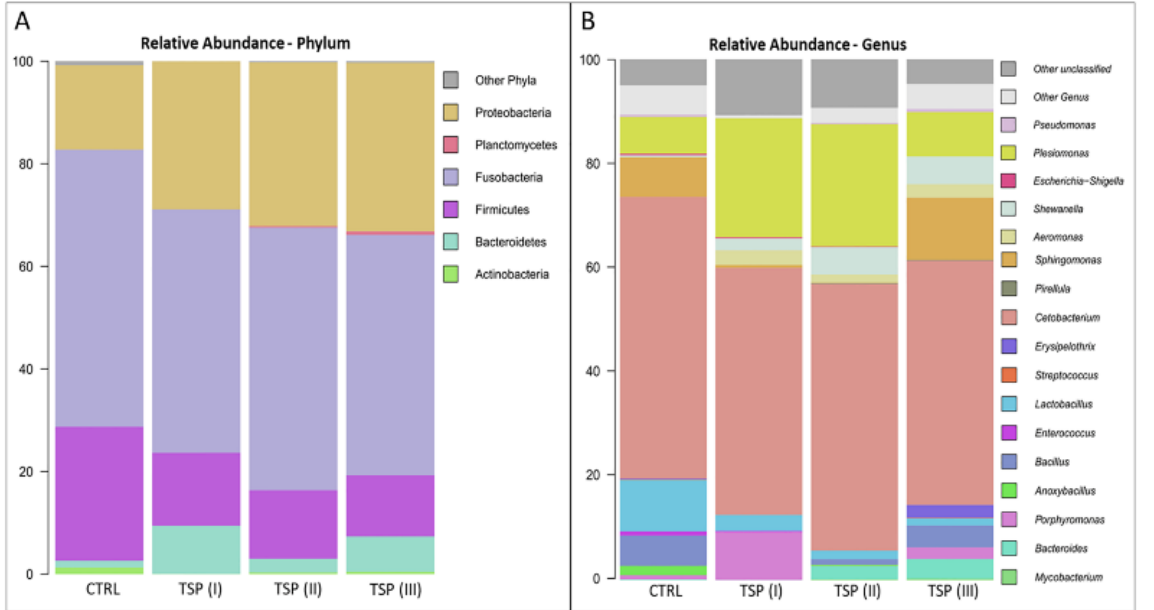
Figure 6. Microbiome compositions of the whole intestines of zebrafish fed a control diet (CTRL), zebrafish fed a diet supplemented with TSP at 0.9 g/kg of feed (TSP I), zebrafish fed a diet supplemented with TSP at 1.7 g/kg of feed (TSP II), and zebrafish fed a diet enriched with TSP at 3.4 g/kg of feed (TSP III). Bar plots summarizing the microbiota compositions at the phylum ( A ) and genus levels ( B ) of CTRL, TSP I, TSP II, and TSP III intestines. Only phyla and genera with relative abundances ≥ 0.5% in at least 2 samples are represented.